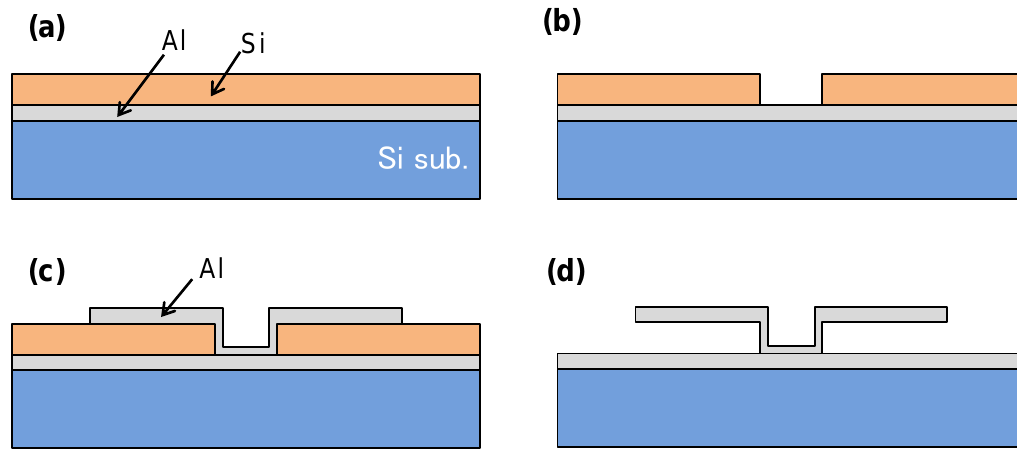
Figure 3. Procedure for fabricating the MPMATs: ( a ) a sacrificial Si layer is formed on a sputtered Al layer over a Si substrate; ( b ) holes are patterned on the Si layer by reactive ion etching (RIE); ( c ) an upper Al layer is added by sputtering and is patterned to form the upper micropatches; and ( d ) the sacrificial layer is removed by XeF 2 to complete the MPMAT.